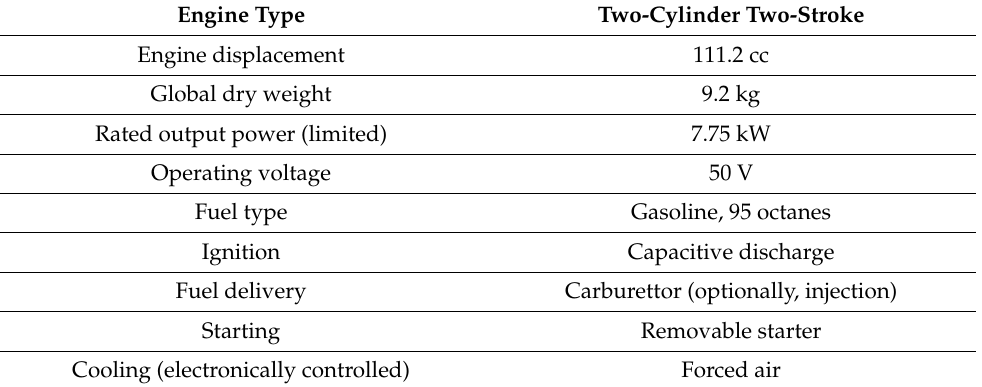
Table 3. Prototype general